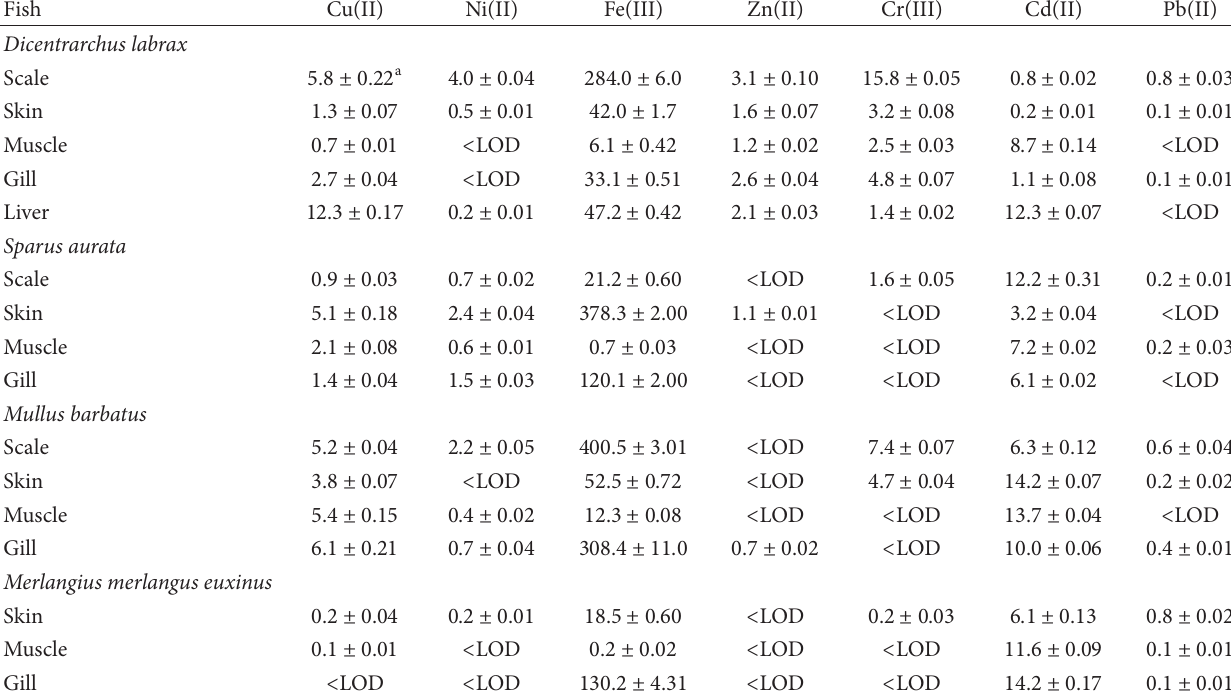
Table 5: Concentration (mg/kg) of metals in different parts of the fish species ( 𝑁 = 5 ).